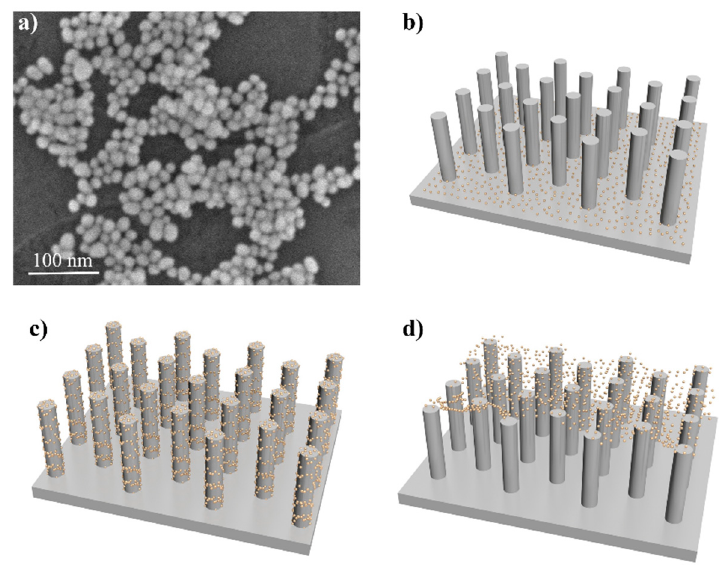
Figure 2. Conjugation of AuNPs on different sites of SiNRs. ( a ) SEM image of synthesized AuNPs; ( b ) B-SiNRs@AuNPs substrate; ( c ) S-SiNRs@AuNPs substrate; ( d ) T-SiNRs@AuNPs substrate.